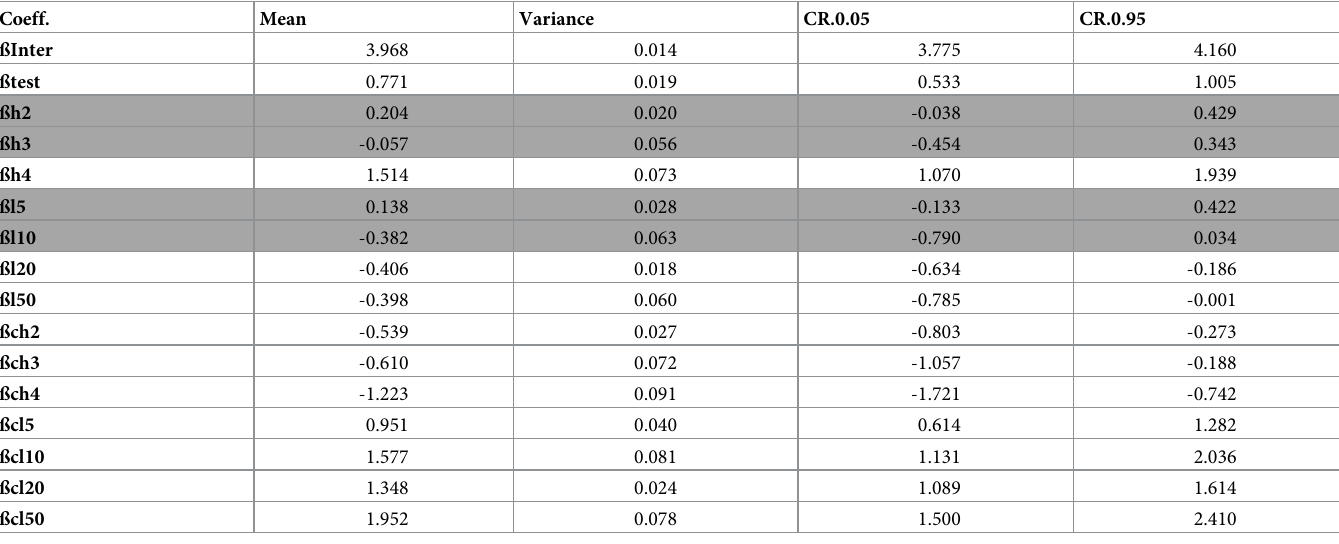
Table 5. β coefficients summary statistics from the posterior distributions (last 10,000 iterations).